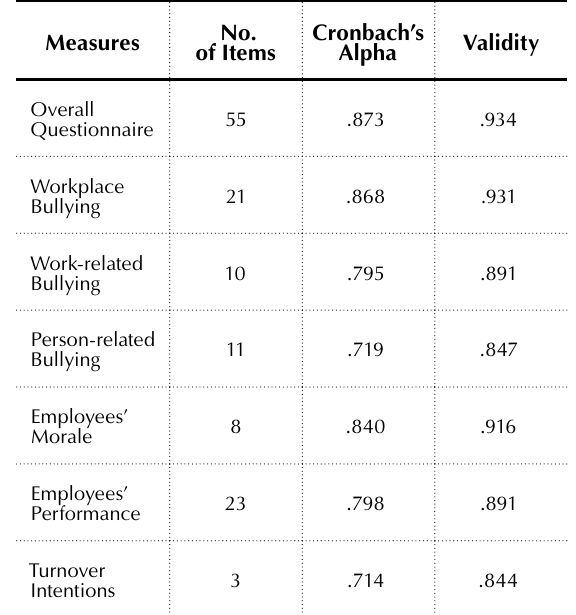
Table 1. Reliability and validity test